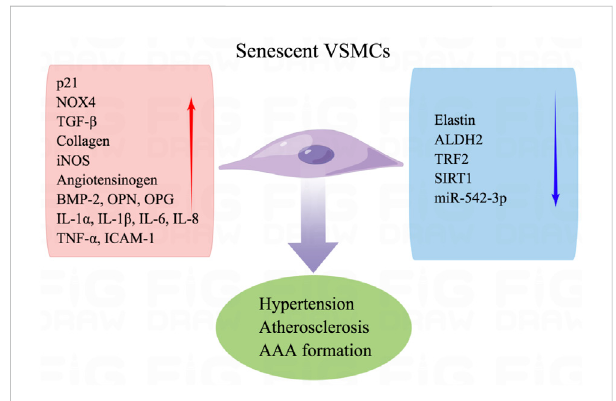
FIGURE 4 Senescence of VSMCs contributes to vascular dysfunction. Senescent VSMCs are attributed to hypertension, atherosclerosis, and AAA formation. Aging VSMCs exhibit aggravated p21, NOX4, TGF- β , collagen, iNOS, angiotensinogen, BMP-2, OPN, OPGIL-1 α , IL-1 β , IL-6, IL-8 TNF- α , and ICAM-1. Besides, decreased elastin, ALDH2, TRF2, SIRT1, and miR-542-3p are observed in senescent